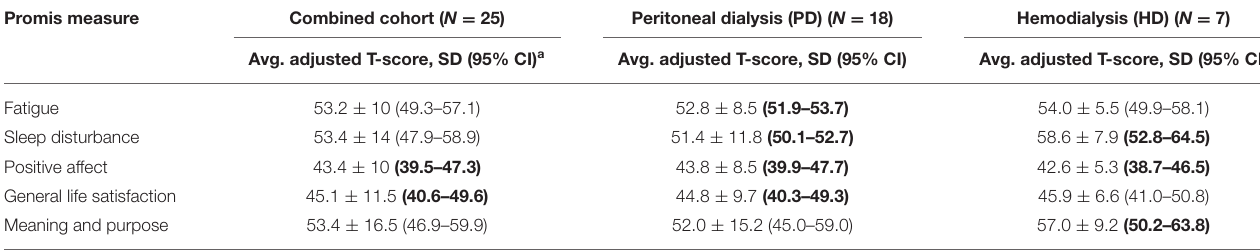
TABLE 3 | PROMIS caregiver average adjusted T-score, confidence interval, and SD.